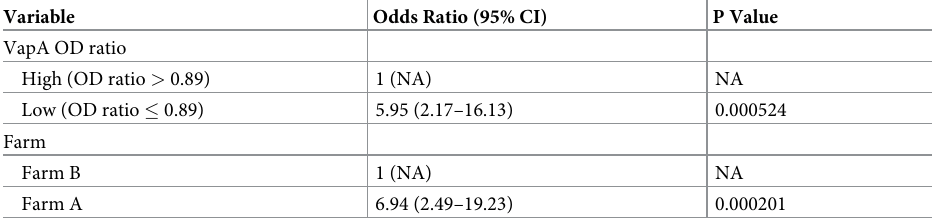
Odds ratios (and 95% CIs) estimated using logistic regression for the outcome of pneumonia attributed to R . equi among 117 foals transfused with R . equi hyperimmune plasma (RE HIP) at both Farm A and Farm B. A binary VapA activity-level variable was created using the median value of VapA of the optical density (OD) ratio for the group of foals was included in the model as well as a variable of farm to account for the potential effects of differences between farms in the method of